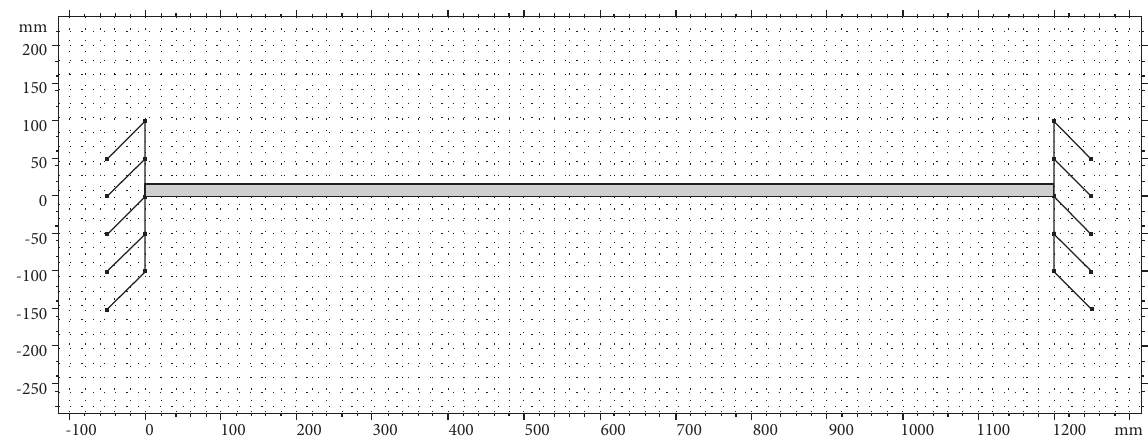
Figure 2: Single-span tube bundle